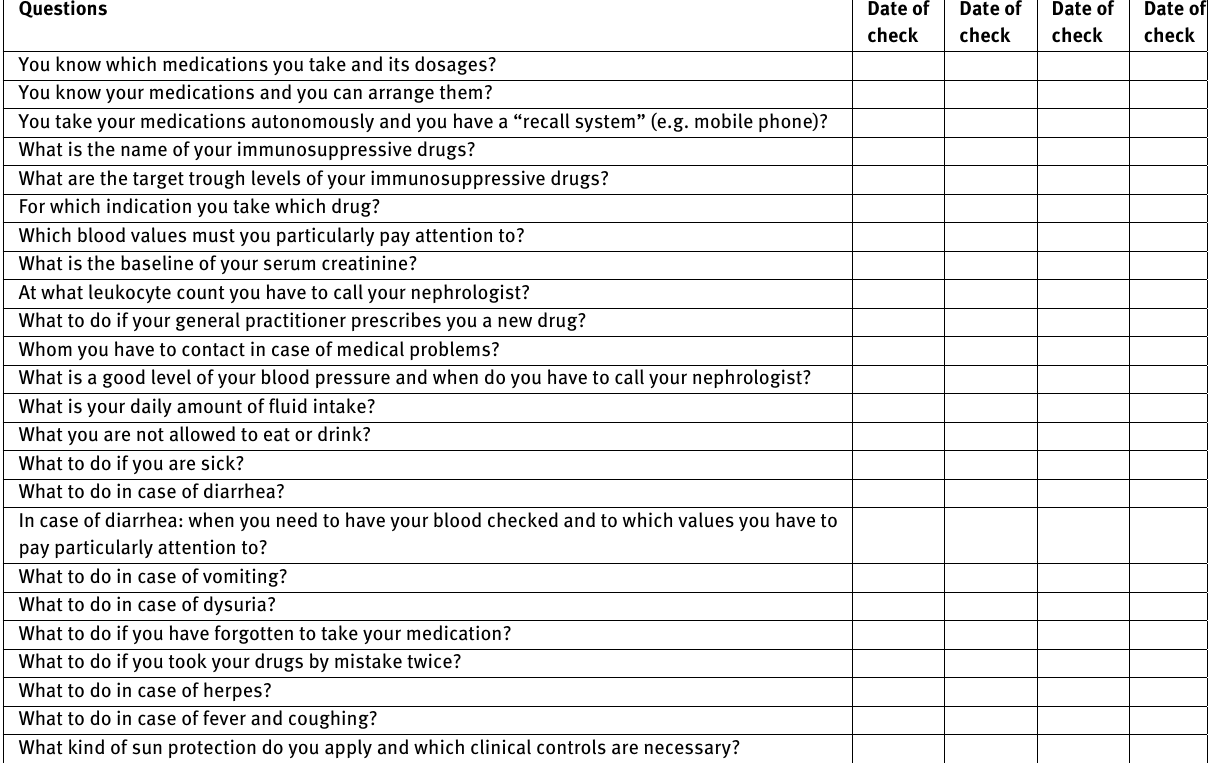
Table 3: Medical checklist for adolescents ≥ 18